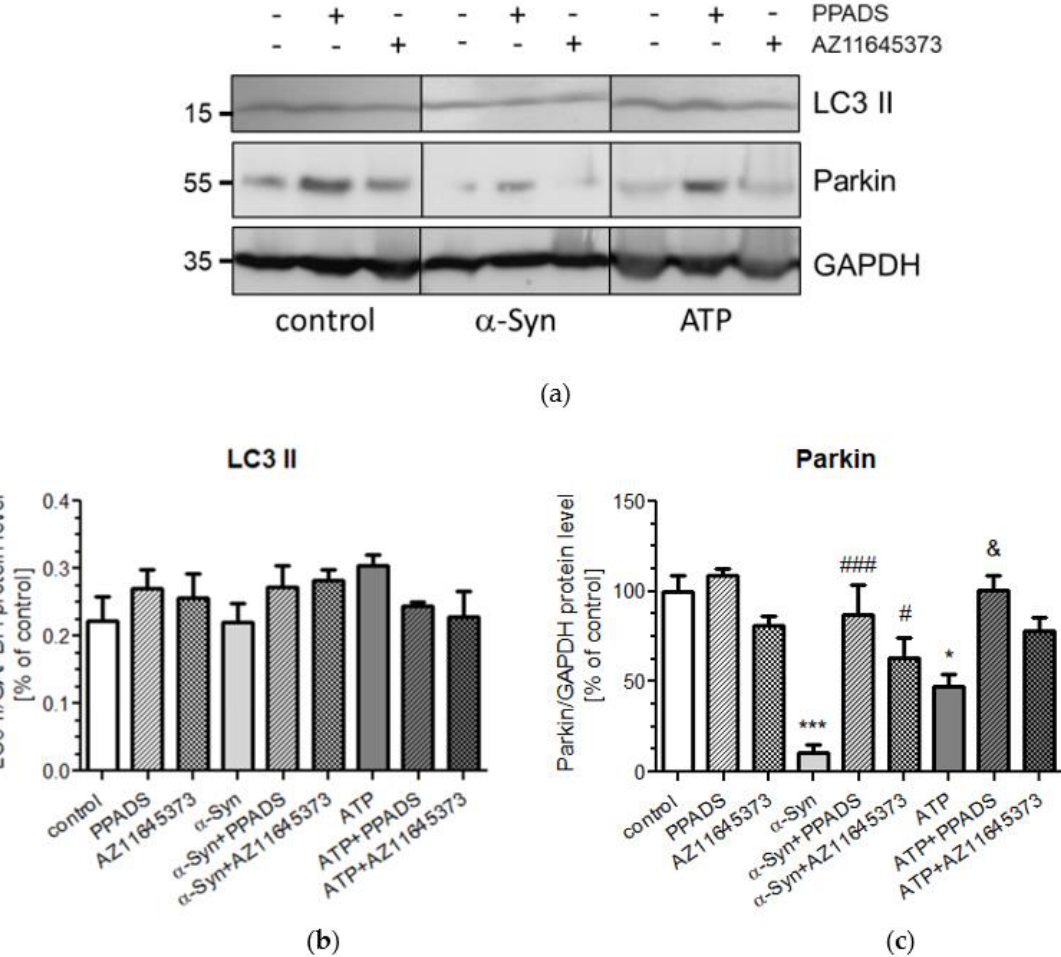
Figure 6. P2X7R activation induced by α -Syn treatment does not change the protein level of LC3 β II but decreases parkin level in SH-SY5Y cells. ( a ) SH-SY5Y cells were treated with 10 µ M α -Syn or 1 mM ATP for 24 h in the presence of 100 µ M PPADS or 10 µ M AZ 11645373. Protein levels of LC3 β II and parkin were then analysed by Western blotting. GAPDH was used as the loading control. “ + ” with treatment; “-“ without treatment ( b ) LC3 β II immunoreactivity normalized to GAPDH in SH-SY5Y cells. Data were normalized to the untreated control group ( = 100%) and represent the mean value ± S.E.M. for three to seven independent experiments. ( c ) Parkin immunoreactivity normalized to GAPDH in SH-SY5Y cells. Data were normalized to the untreated control group ( = 100%) and represent the mean value ± S.E.M. for four independent experiments. * p < 0.05; *** p < 0.001 compared to control, # p < 0.05; ### p < 0.001 compared to α -Syn, and & p < 0.05 compared to ATP using one-way ANOVA followed by Bonferroni post hoc test.